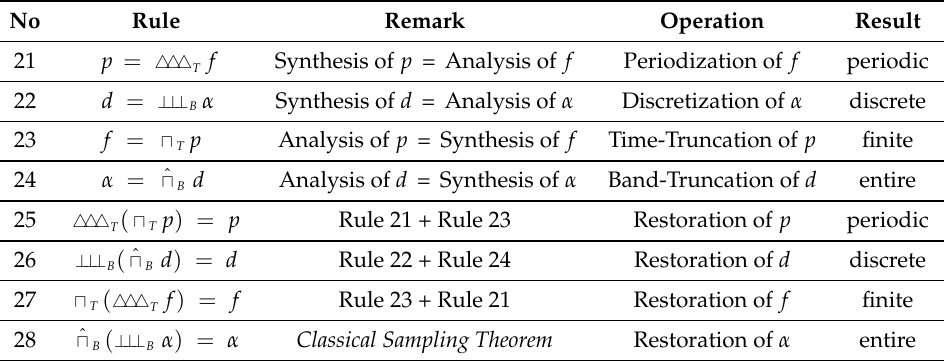
Table A3. Discrete/Periodic and Time/Band-limited Functions—Synthesis &